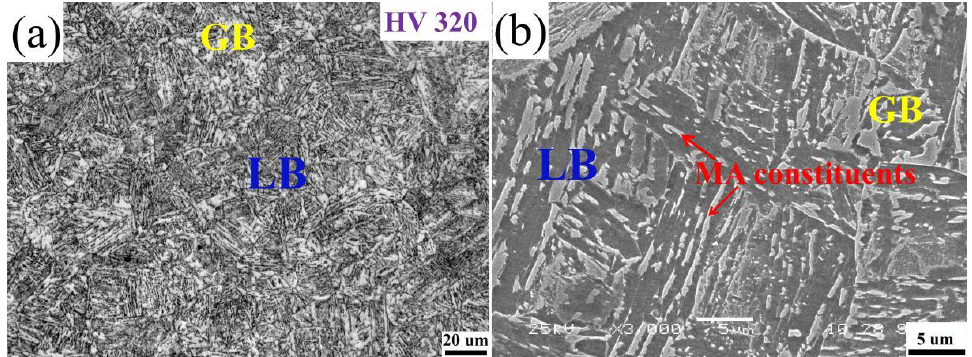
Figure 3. The OM ( a ) and SEM ( b ) of micrographs of as-quenched samples of heavy-wall heat Induction seamless bend pipe.